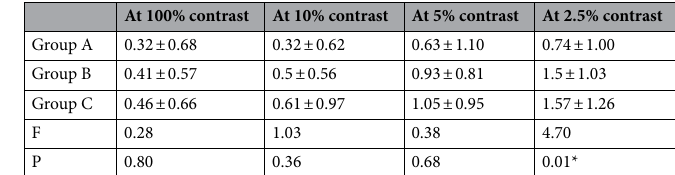
Table 3. The average BiS records (x ± s lines) for high contrast and different low contrast in three groups after strabismic surgeries. *P < 0.05.